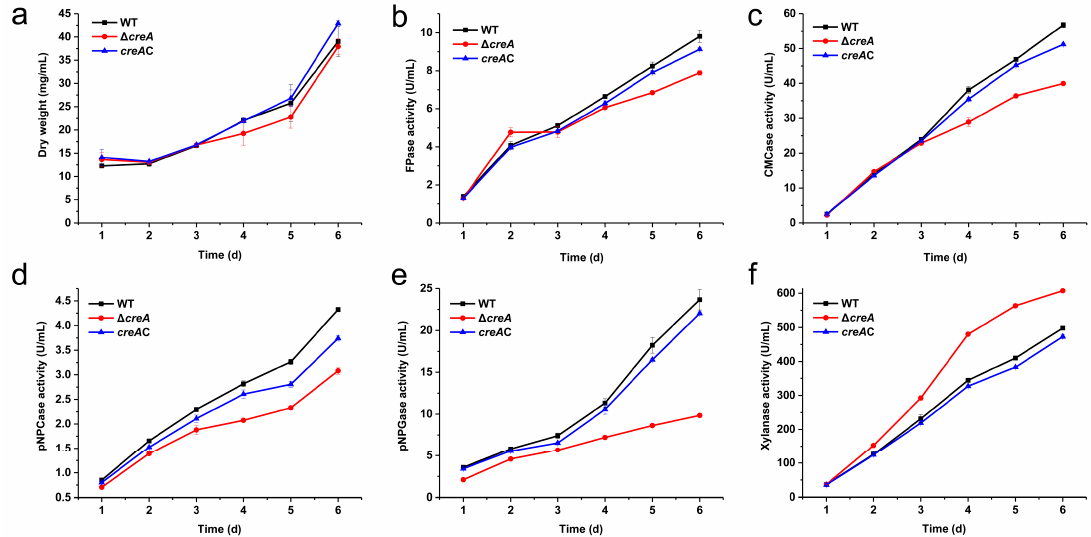
Figure 5. Cellulase activities of H. insolens WT, creA disruption mutant, and creA complement strains under inducing conditions. Dry weight ( a ), FPase activity ( b ), CMCase activity ( c ), pNPCase activity ( d ), pNPGase activity ( e ), and xylanase activity ( f ) were measured from shake-flask fermentation cultures grown at 42 °C for 6 days using 2.0% ( w/v ) Avicel as the carbon source.